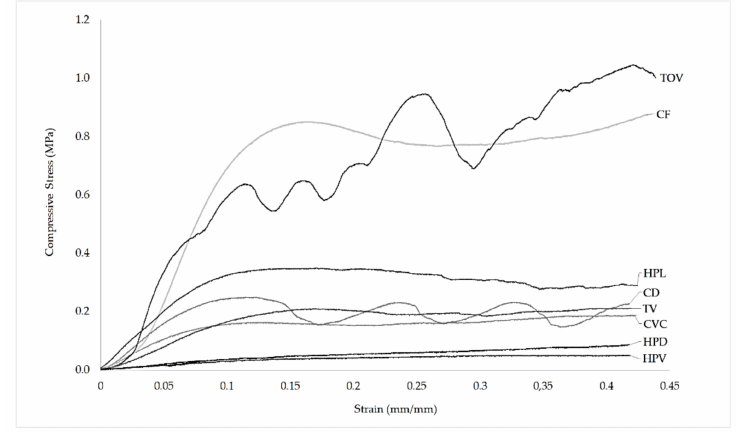
Figure 6. Stress-strain diagram for the eight ABS lattice structures.